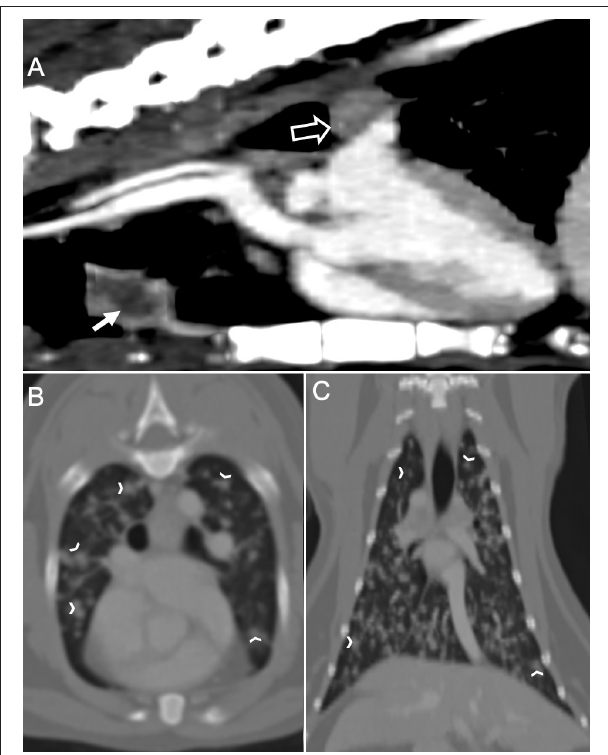
FIGURE 2 | Computed tomography of the thorax in a cat with a compressive Coccidioides spp. spinal granuloma before surgery or administration of fluconazole. (A) Sagittal plane reconstruction with soft tissue window display. The sternal lymph node was enlarged (sold white arrow) with a peripheral contrast enhancement. There was also enlargement of the tracheobronchial lymph node (hollow white arrow); (B) Transverse plane reconstruction with bone window display, and (C) Dorsal plane reconstruction with bone window display. There were numerous, irregular, small soft tissue nodules (white chevrons) within all lung lobes.